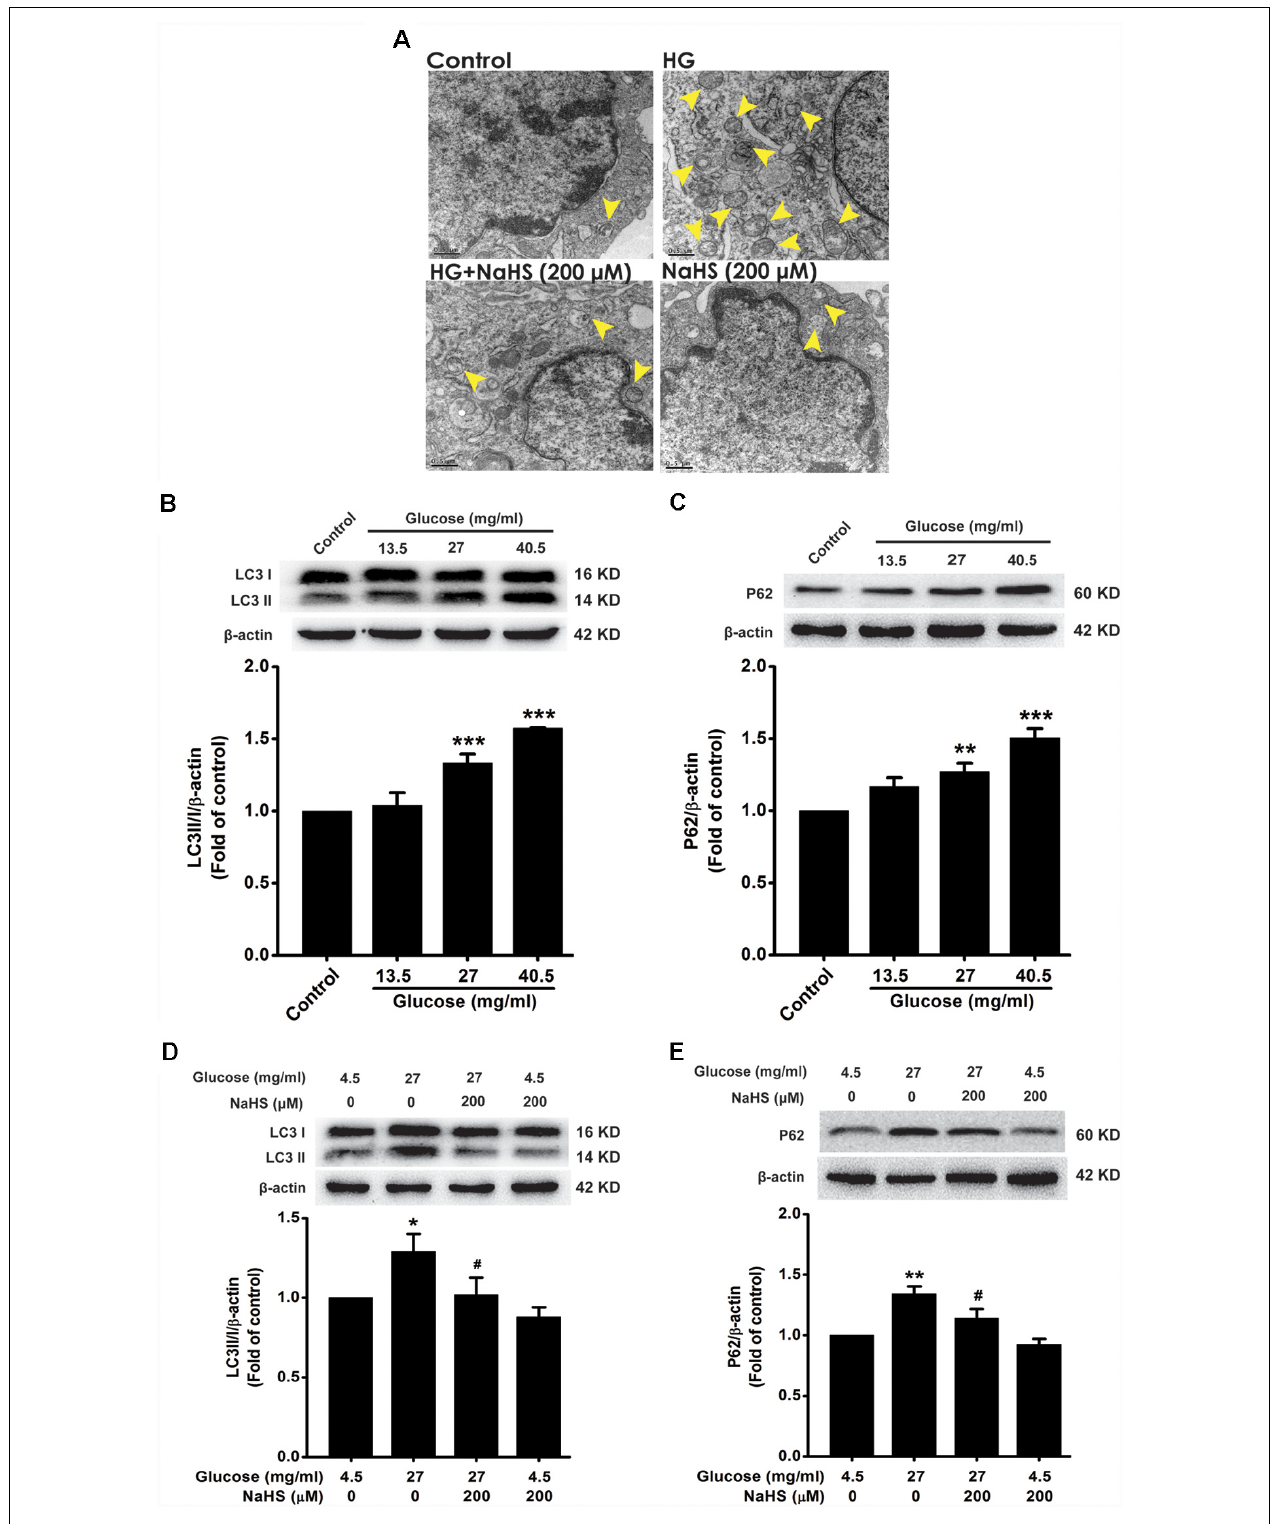
FIGURE 2 | Effect of H 2 S on HG-elicited disruption of autophagic flux in HT22 cells. (A) Transmission electron microscope observed the number of autophagosome. The yellow arrows indicate autophagosome. (B–E) The expressions of LC3II/LC3I and P62 in HT22 cells were detected by Western blotting. Values were expressed as the mean ± SEM, n = 3. ∗ P < 0.05, ∗∗ P < 0.01, ∗∗∗ P < 0.001, vs. control group; # P < 0.05, vs. HG-treated alone group.